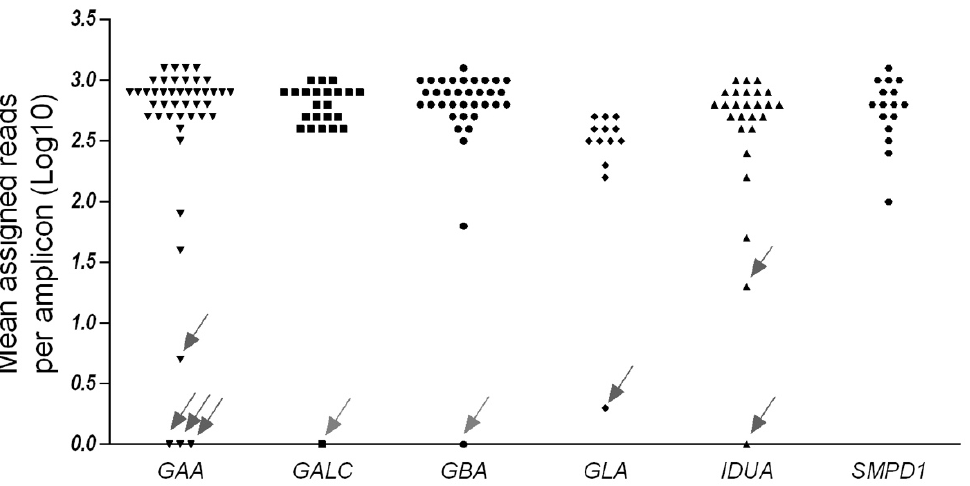
Figure 1. Amplicon coverage of target genes. A total of 157 amplicons distributed across six genes were amplified and sequenced with the made-to-order Ion AmpliSeq NBS_LSDs panel. This chart shows the mean coverage of individually targeted amplicons across each gene for 15 standard samples. The arrows indicate the amplicons with low amplification efficiency. Amplicons with zero reads were arbitrarily represented as 0 Log10.